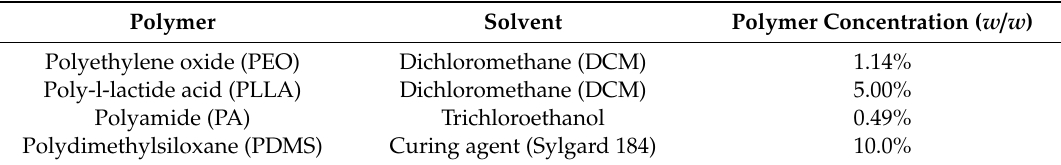
Figure 1. Fabrication procedure: ( a ) Substrate; ( b ) Polymer coating; ( c ) Scotch tape pasted over the polymer layer; ( d ) poly-dimethylsiloxane (PDMS) coating; ( e ) Removal of the Scotch tape; ( f ) Sealing with PDMS slab with the microchannel imprinted in it. Table 1. Polymers and solvents used to prepare polymeric solutions.